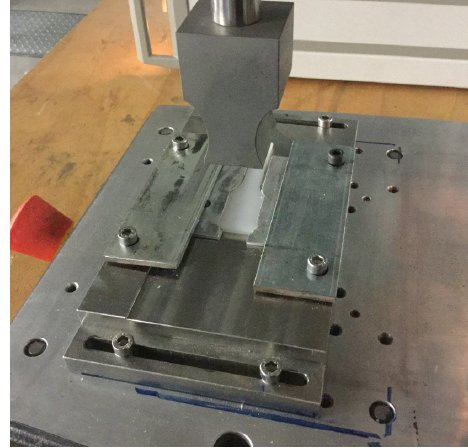
Figure 2. Specimen clamping system.